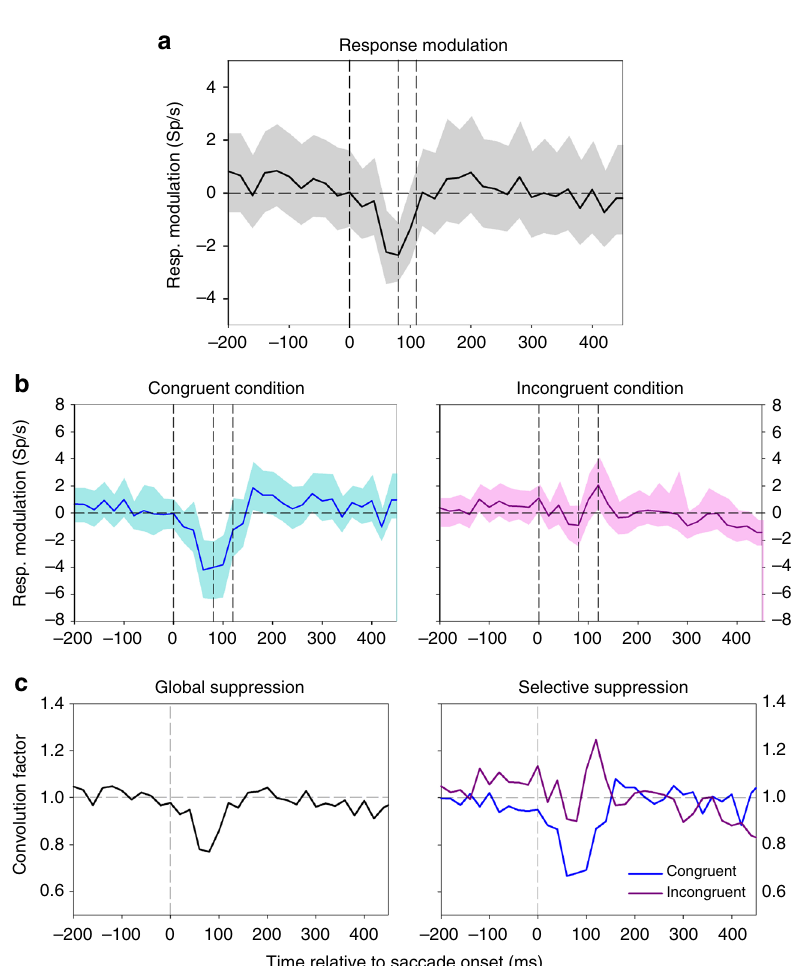
Fig. 3 Global and selective response modulation at the population level. a We fi rst computed for each neuron its time-resolved discharge in the time window [ − 200 ms 450 ms] and subtracted the mean activity in this window from the time-resolved discharge, providing a neuron ’ s perisaccadic response modulation. We then averaged these response modulations across all 71 neurons. The solid black line depicts this mean response modulation, the gray surround indicates the 95% con fi dence interval as determined from bootstrapping. The vertical dashed lines indicate (i) saccade onset (0 ms), (ii) the time-point of maximum suppression (80 ms), and (iii) the time-point of maximum compression (110 ms). b When neurons were stimulated with their preferred heading direction (congruent condition, left panel, blue curve), saccadic suppression of activity was observed. When the same neurons were stimulated with their non-preferred heading (incongruent condition, right panel, purple curve), no saccadic suppression, but rather a signi fi cant response enhancement could be observed. In both panels, the solid lines indicate the time resolved response modulation, while the shaded, colored areas indicate the 95% con fi dence interval as determined from bootstrapping. Vertical dashed lines as in a . c For the quantitative model on the role of saccadic suppression on heading decoding we convoluted the time courses of the arti fi cial neurons with the response pro fi les deduced from global suppression or selective suppression, respectively. These kernels were obtained by normalizing the time courses of (i) global suppression (black line, left panel), (ii) selective suppression occurring during congruent stimulation (blue line, right panel), and (iii) response enhancement occurring during incongruent stimulation (purple line, right panel) such that the values > 100 ms before and after the saccade were centered on VIP to be split up into two subpopulations: neurons that were tuned for leftward headings constituted “ Subpopulation 1 ” . By de fi nition, the slope m of the regression function fi tted to the heading responses of these neurons was smaller than zero ( m < 0). “ Subpopulation 2 ” comprised those neurons that are tuned for rightward headings ( m > 0). This procedure is graphically illustrated in Fig. 4a. Published data predict that from such a grand population of MST and/or VIP neurons, roughly the same number of neurons should fall into one of the two subpopulations 15, 17, 21 – 23 . Indeed, in our data set of n = 71 neurons, n Subpop1 = 38 neurons were tuned for leftward self- motion ( m < 0), while n Subpop2 = 33 were tuned for rightward self-motion ( m > 0).